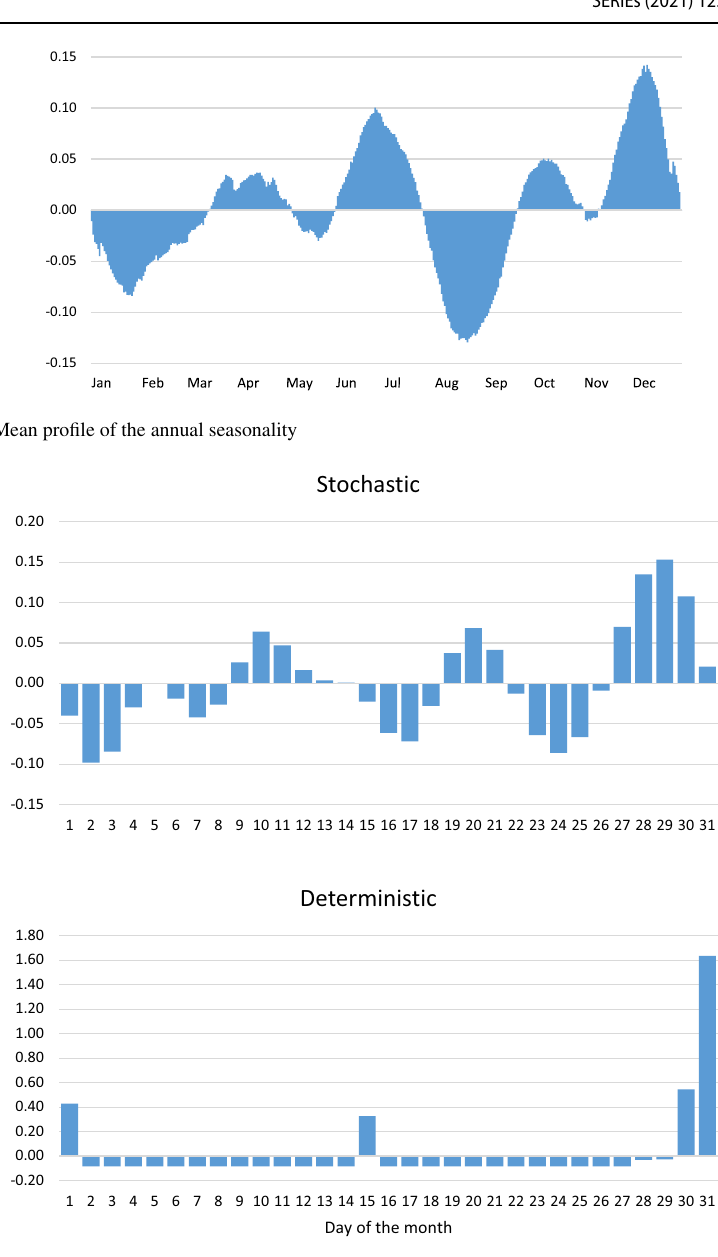
Fig. 7 Mean profile of the monthly